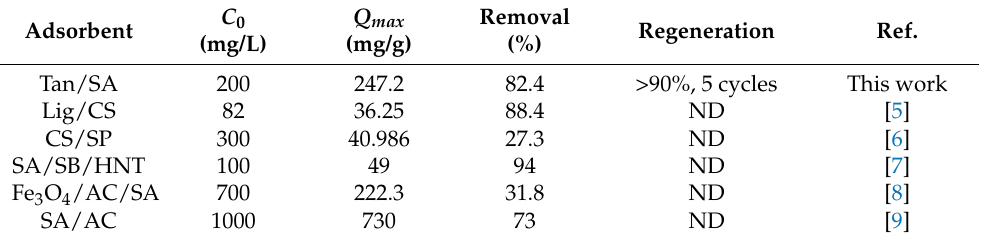
Table 3. Comparison of the MB removal performance with similar adsorbents.